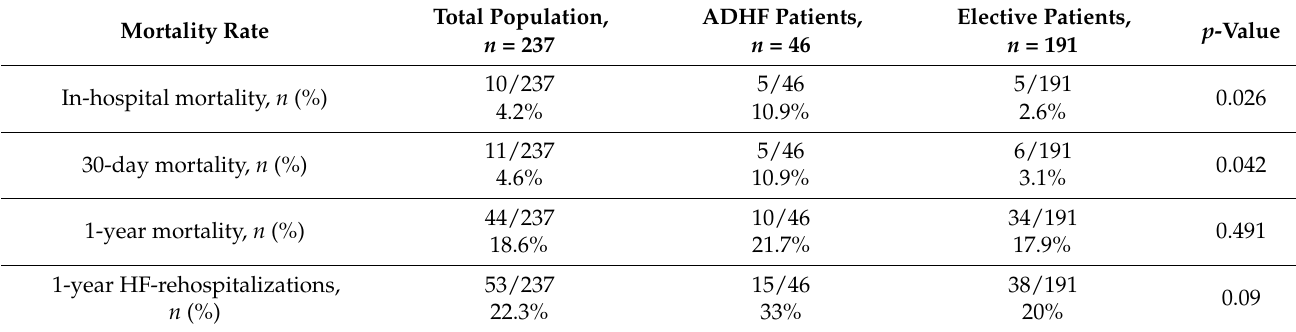
Table 5. Mortality and 1-year rehospitalizations rate of patient population that underwent PMVr. Mortality Rate